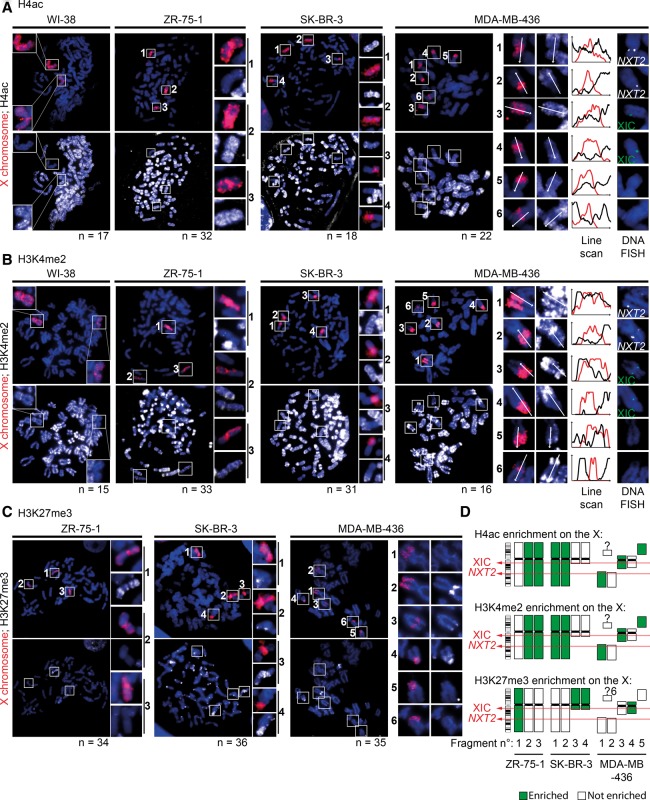
The inactive X chromosome is still epigenetically distinguishable from its active counterpart. (A) Representative examples of immunofluorescence show the status of H4ac (white) depletion/enrichment on X chromosomes (X-paint DNA FISH, red) on metaphase spreads from normal (WI-38) and breast cancer cell lines (ZR-75-1, SK-BR-3, and MDA-MB-436). On the right, MDA-MB-436 cells carry six X-chromosome fragments with a “2-by-2” homology, as assessed by the presence or absence of the NXT2 (white) or XIC loci (green), and line scans show H4ac enrichment variation between these X-fragments and the neighboring autosomal regions. As expected, one X chromosome (Xi) lacks H4ac staining in normal WI-38 cells (and HMEC, not shown). ZR-75-1 and SK-BR-3 cell lines harbor a reduced H4ac staining on one and two X chromosomes, respectively, in agreement with the number of XIST-coated X chromosomes shown in Figure 1A. In MDA-MB-436 cells, homologous X-chromosome fragments (two containing the XIC locus, two containing the NXT2 locus, and two with none of them) display opposite H4ac staining, suggesting that there is still one inactive and one active X chromosome linked to those loci, although fragmented. (B) Representative examples of immunofluorescence show the status of H3K4me2 (white) depletion/enrichment on X chromosomes (X-paint DNA FISH, red) on metaphase spreads from normal and breast cancer cell lines. On the right, line scans show H3K4me2 enrichment variation between the six X-fragments (for details, see A) and the neighboring autosomal regions in MDA-MB-436 cells. In each tumoral cell line, H3K4me2 depletion patterns follow the H4ac profiles found in A. (C) Representative examples of immunofluorescence show the status of H3K27me3 (white) enrichment on X chromosomes (X-paint DNA FISH, red) in metaphase spreads from breast cancer cell lines. ZR-75-1 and SK-BR-3 cell lines harbor an accumulation of H3K27me3 on one and two X chromosomes, respectively, in agreement with the number of XIST-coated X chromosomes shown in A. In MDA-MB-436 cells, H3K27me3 staining was only enriched on the X-chromosome fragment, where the XIC region lies. Indeed, RNA/DNA FISH analysis showed that this X fragment corresponds to the one coated by XIST RNA in interphase cells, which is not the case for the other fragments (Supplemental Fig. S3F). In SK-BR-3 and MDA-MB-436 cell lines, H3K27me3 spreads into the autosomal fragments translocated to the XIC-containing fragment. (D) Schematic view of H4ac, H3K4me2, and H3K27me3 patterns on X-chromosomes in the three tumor cell lines.